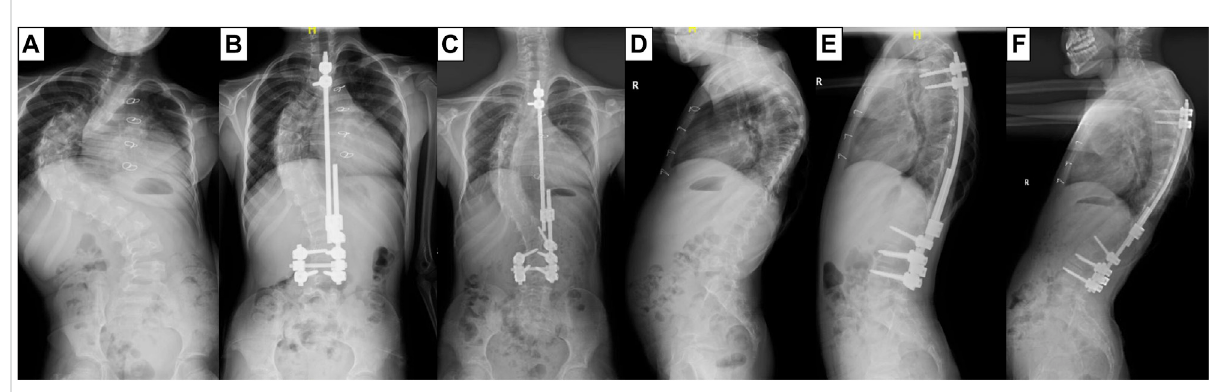
FIGURE 1 X-ray fi lm of the patient before GR surgery (A,D) , after surgery (B,E) and at the follow-up (C,F)